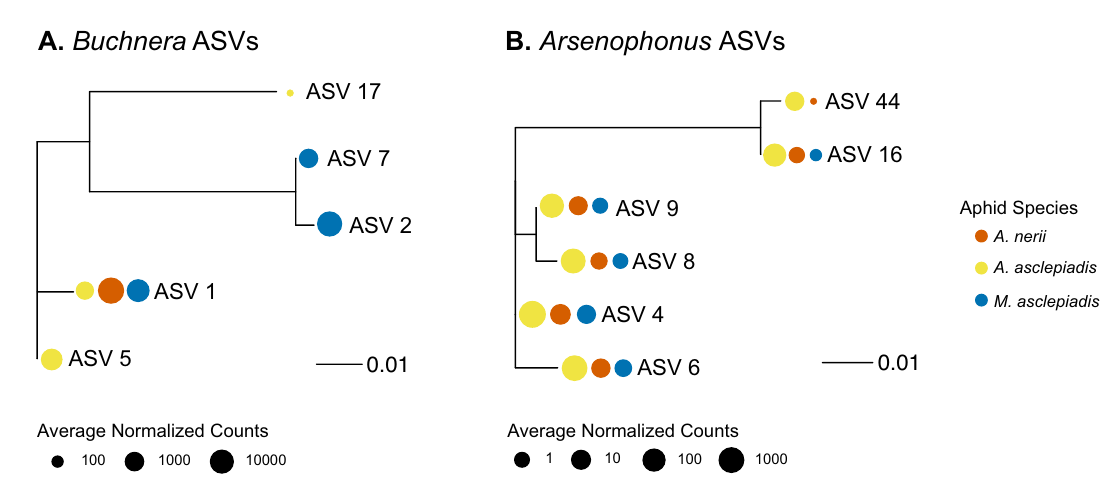
Figure 5. Genetic variation and differences in relative abundance of Buchnera and Arsenophonus strains (ASVs) identified in the three milkweed aphid species. All Buchnera and Arsenophonus ASVs were differentially abundant (adjusted p < 0.05) in at least one species comparison by DESeq2 (Supplementary Table S6). Figure panels generated in R and joined using Adobe Illustrator